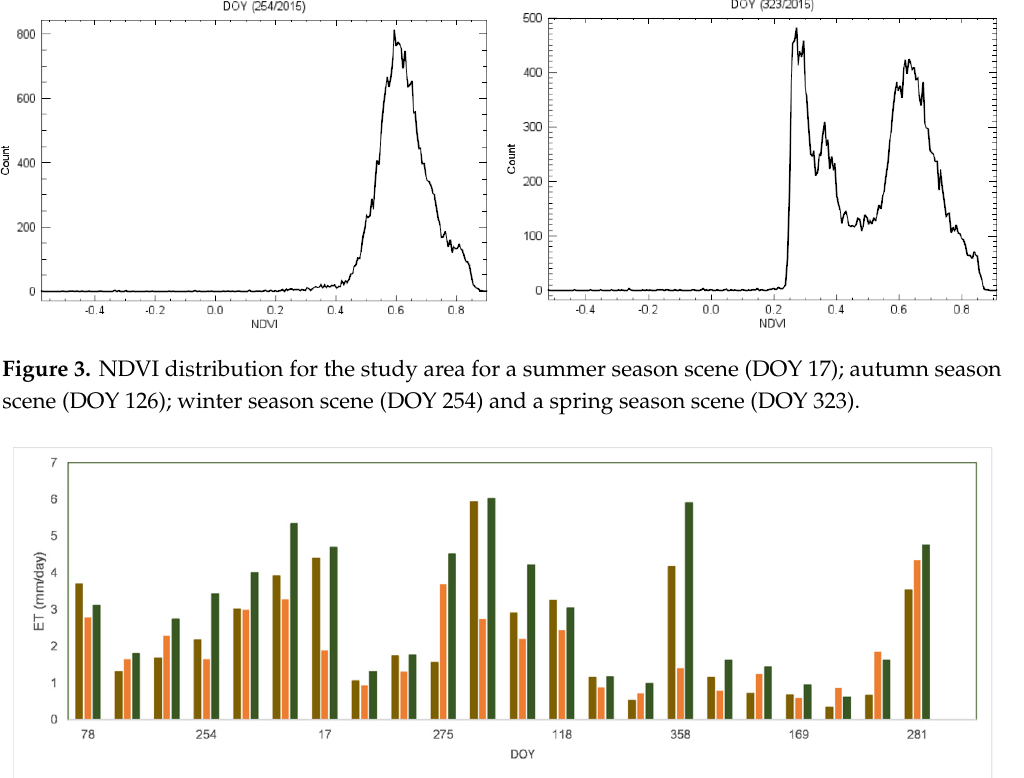
Figure 3. NDVI distribution for the study area for a summer season scene (DOY 17); autumn season scene (DOY 126); winter season scene (DOY 254) and a spring season scene (DOY 323).